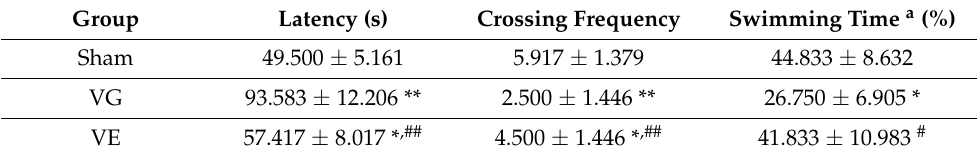
Table 2. The results of the Morris water maze test ( n = 12). Group Latency (s) Crossing Frequency Swimming Time a (%) Sham